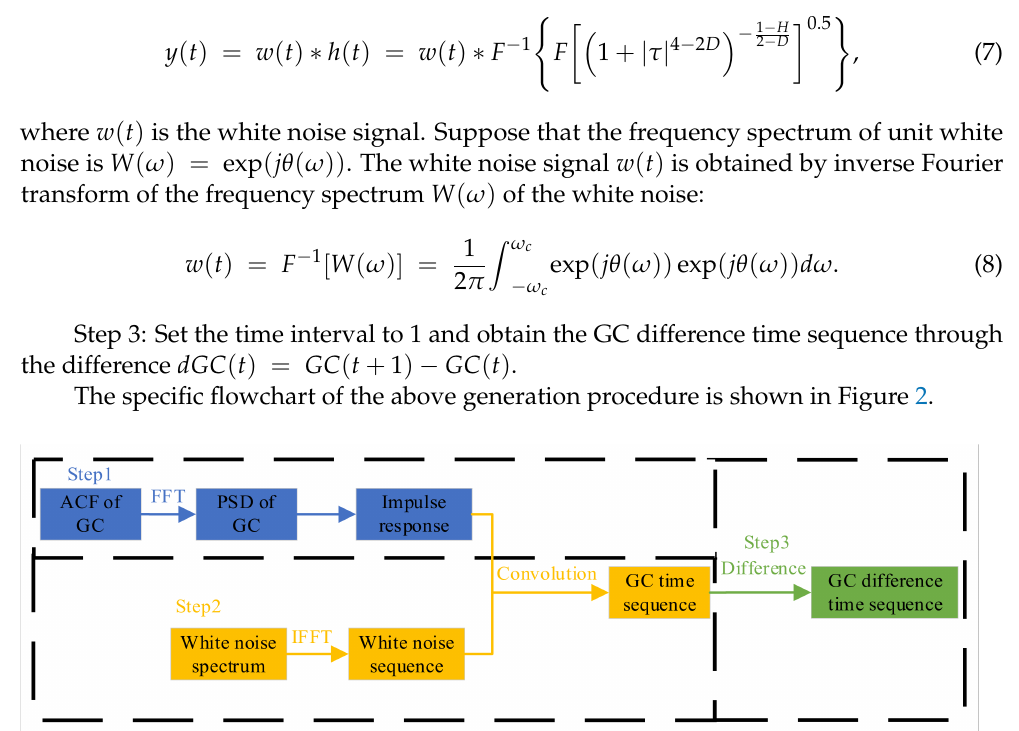
Figure 2. Flowchart of the procedure for generating the difference time sequence. The GC time sequence is generated with D = 1.2 and H = 0.7. The GC difference time sequence is shown in Figure 3.